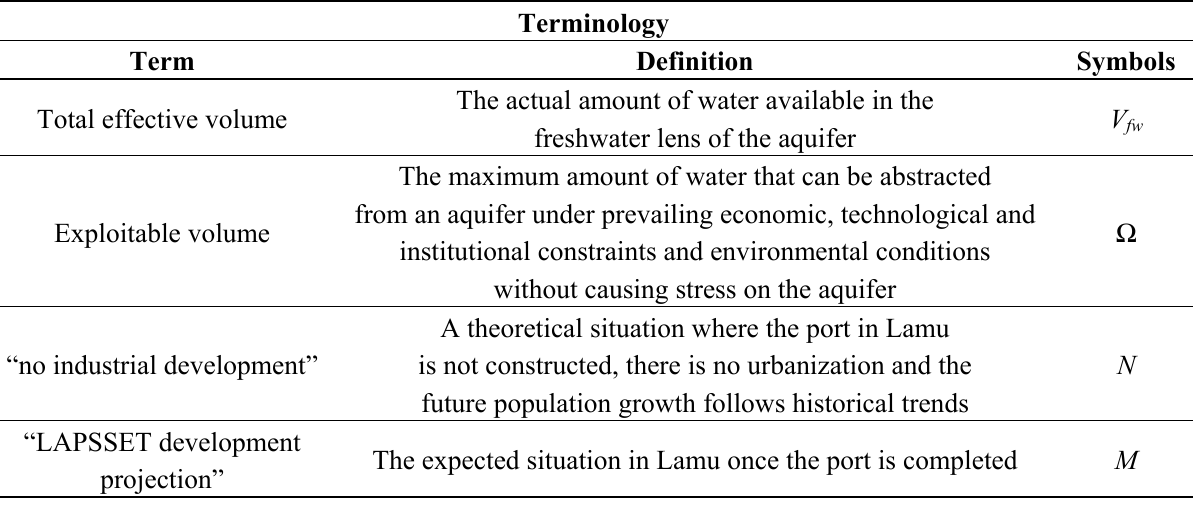
Table 1. Definitions of some terminology used throughout the study. LAPSSET, Lamu-South Sudan-Ethiopia Transport